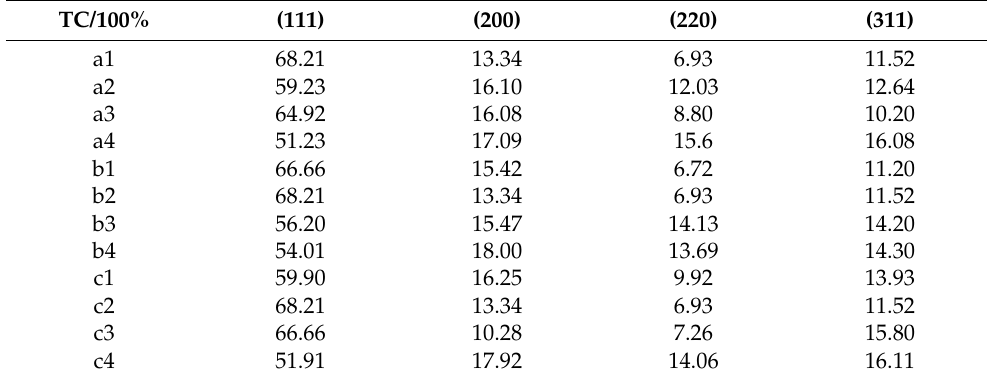
Table 3. The TC value of